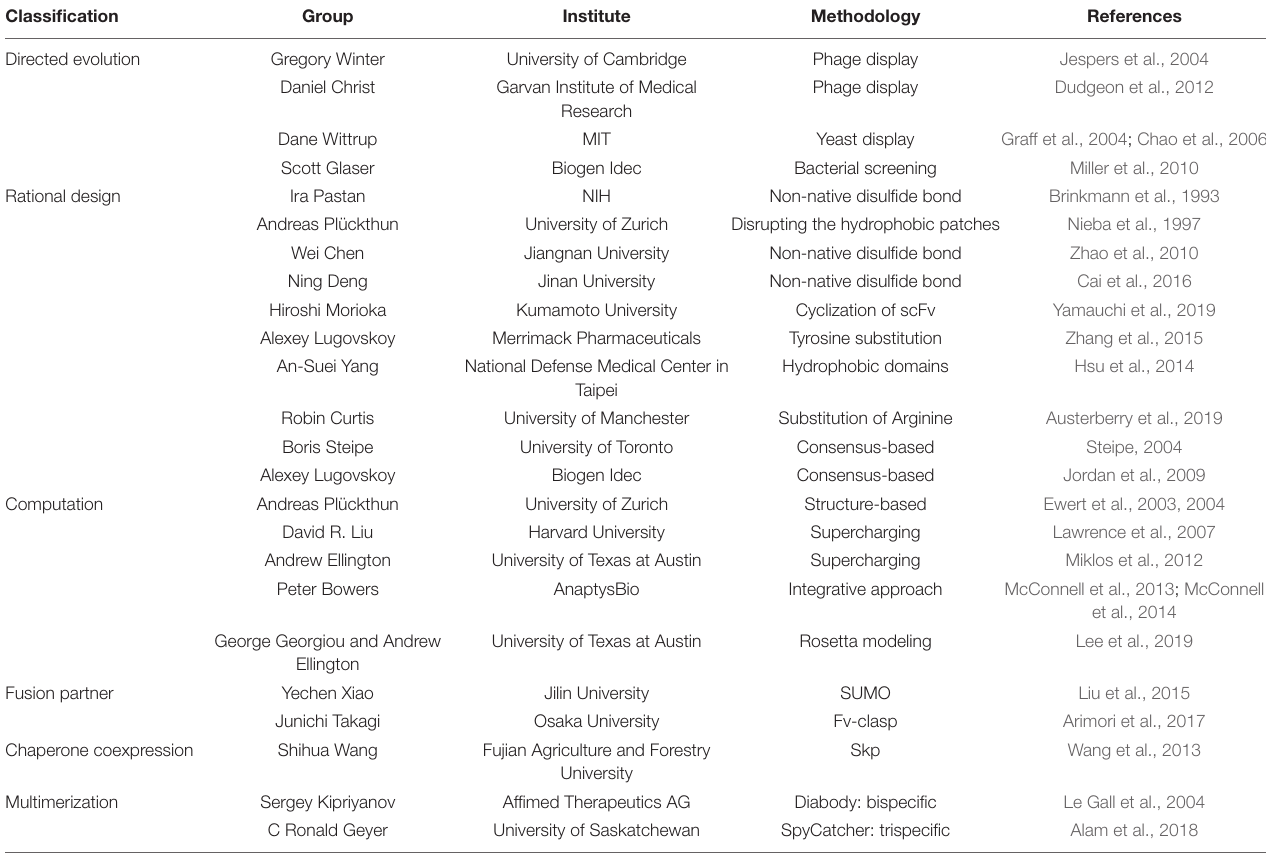
TABLE 2 | Summary of stability and avidity engineering of scFvs in